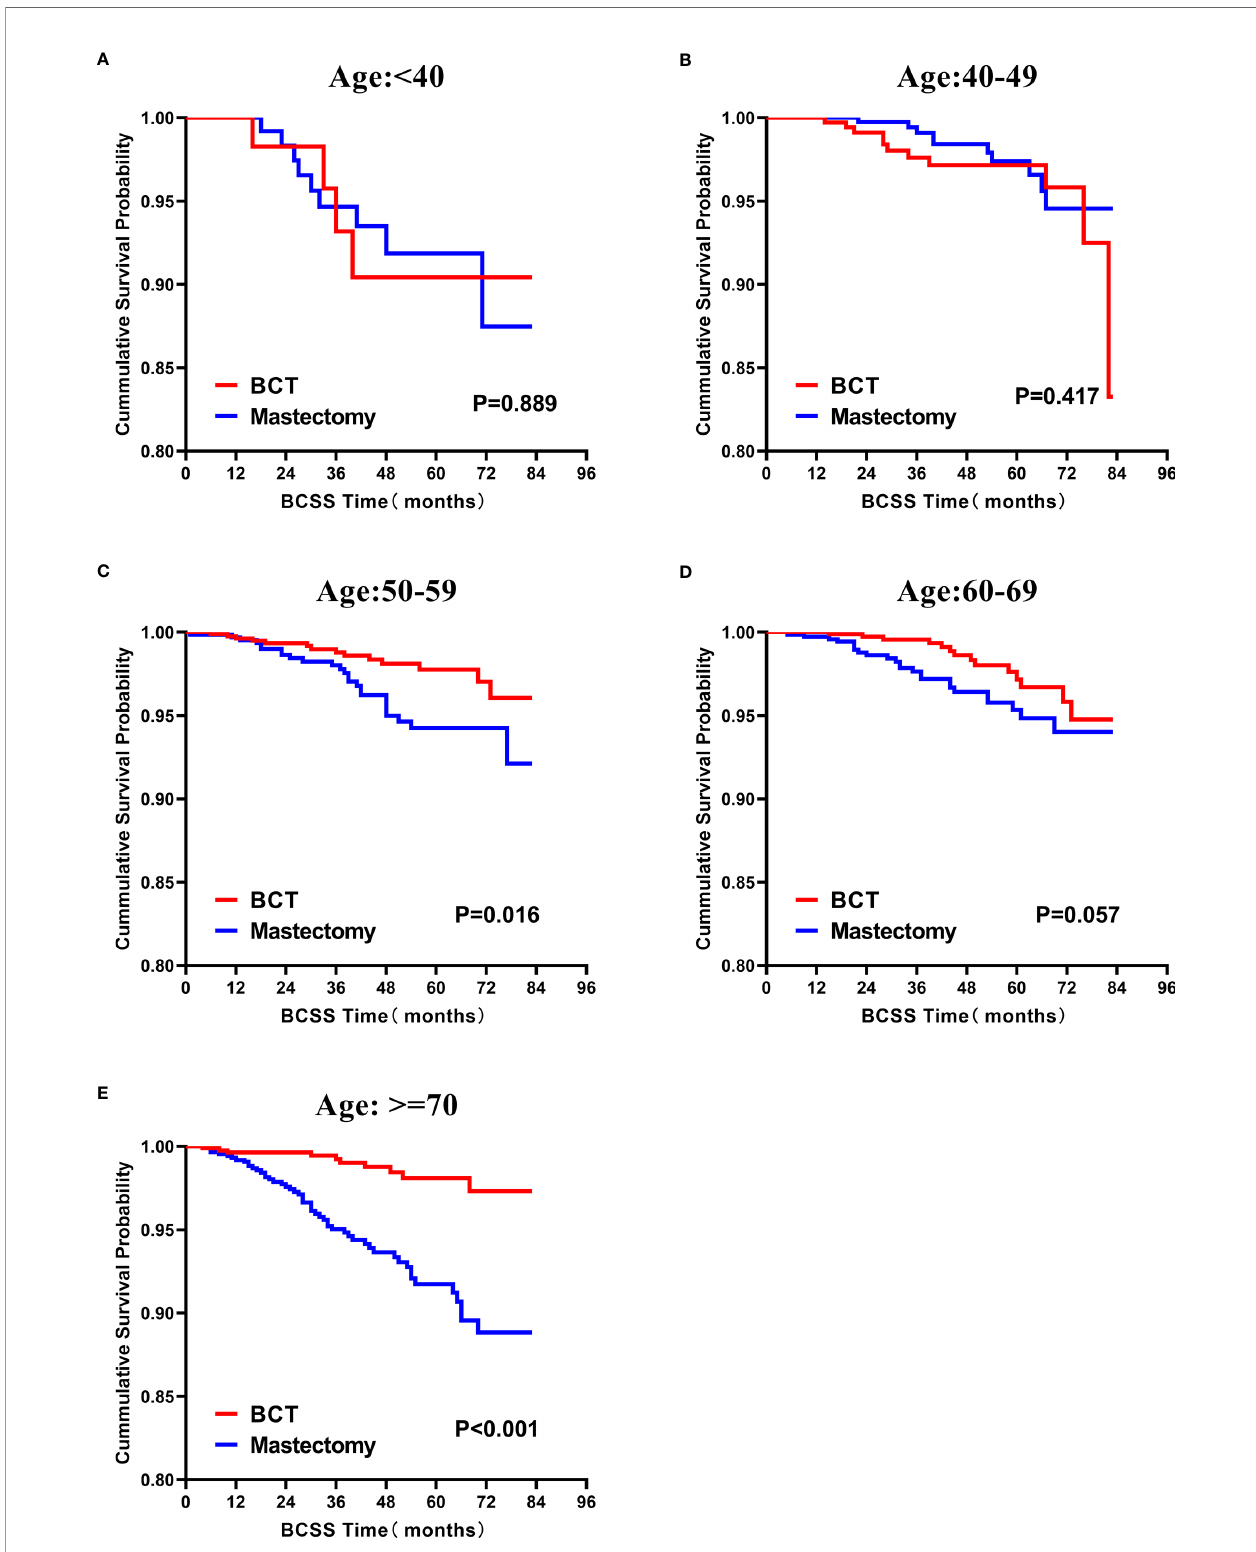
FIGURE 3 | Kaplan – Meier curves for BCSS by treatment type for all patients, strati fi ed by age at diagnosis: (A) Age < 40 years. (B) Age of 40 – 49 years. (C) Age of 50 – 59 years. (D) Age of 60 – 69 years. (E) Age ≥ 70 years. BCSS, breast cancer speci fi c survival; BCT, breast-conserving